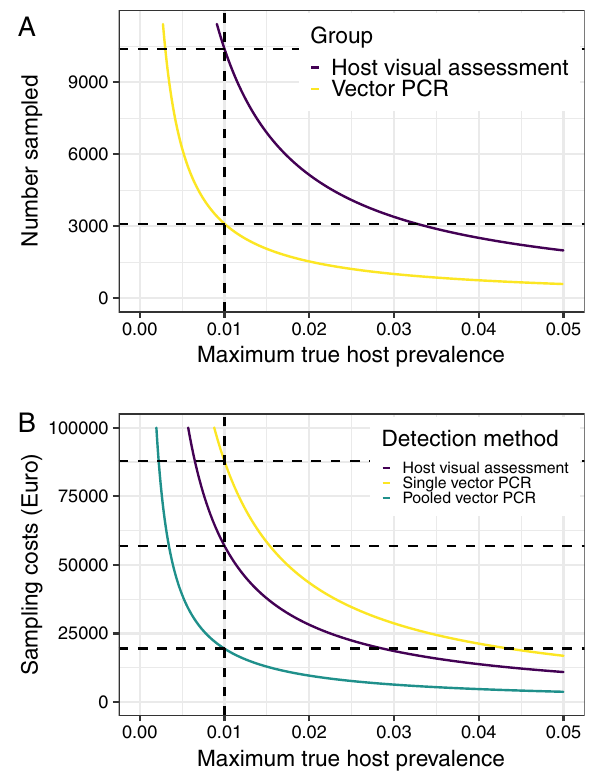
Figure 6. In cases where X. fastidiosa is not thought to be present, fewer vectors than hosts need to be tested in order to declare pest freedom. ( A ) The number of hosts which need to be tested to detect at a given prevalence is over three times higher than the number of vectors. This plot shows the 90th percentile of the host prevalence in the absence of positive detections on the x-axis, and the number of individuals which would have to be sampled (and found to be negative) to achieve this on the y-axis, when hosts or vectors are sampled exclusively. The intersection of the curves and the vertical dashed line represents the sample size required to be 90% confident that the true prevalence is lower than 1% if no detections are made. ( B ) If vectors are pooled, the total cost of sampling hosts is around three times higher than the cost of sampling vectors. This plot shows the 90th percentile of the host prevalence in the absence of positive detections on the x-axis, and the total cost of the required sampling and testing effort to achieve this on the y-axis, when hosts or vectors are sampled exclusively. We assume that hosts are sampled with visual inspection and ELISA confirmation of suspected positives, and that vectors are tested using qPCR, either singly or pooled in batches of